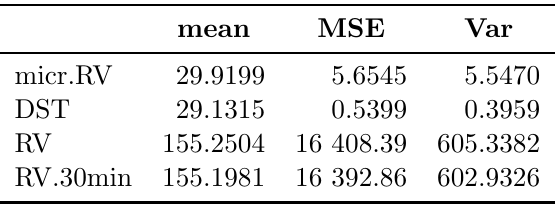
Table 3: Simulation 3. Constant instantaneous volatility and p (1) = − 0 . 48 with noise to signal ratio 3.5. Annualised volatility: